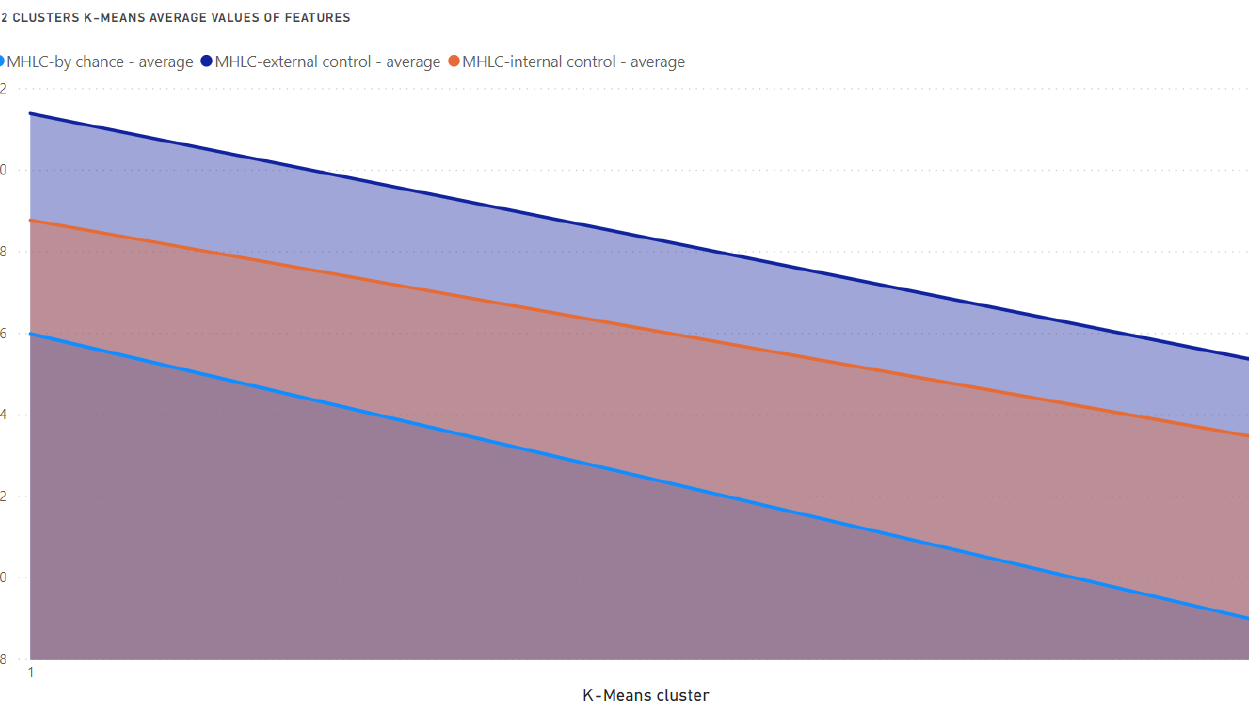
Figure 2. Distribution of 3 analyzed characteristics with 2 clusters generated by K-Means algorithm.